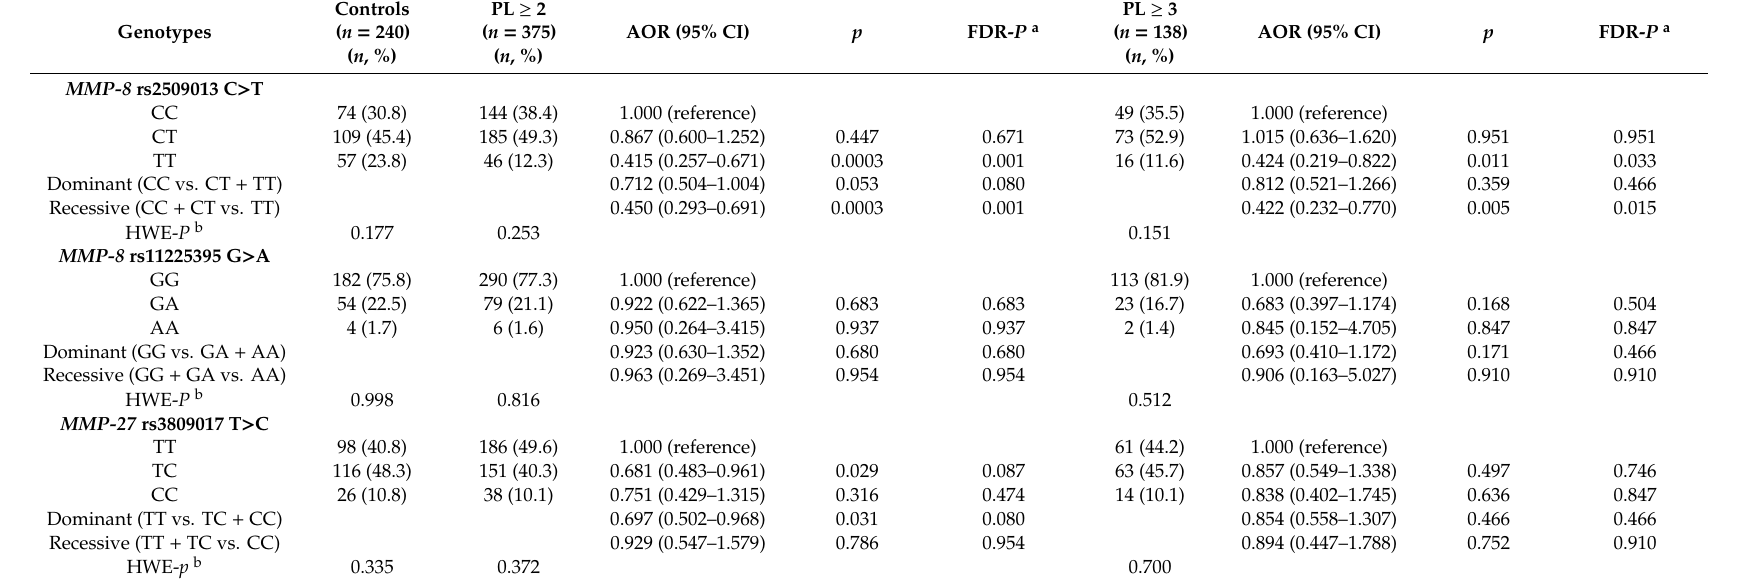
Table 2. Genotype frequencies of MMP gene polymorphisms in the RPL patients and control